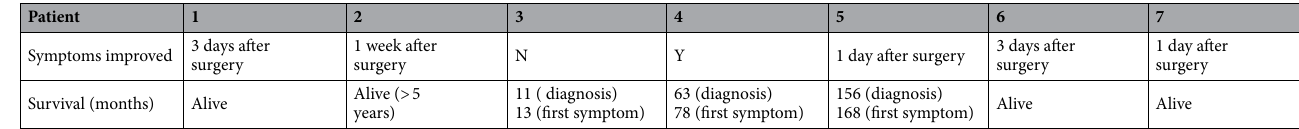
Table 1. Patient presentation, tumor Characteristics and treatments. Normal glucagon levels < 200 pg/ mL. NME Necrotizing migratory erythema, DVT Deep vein thrombosis, IGT Impaired glucose tolerance,